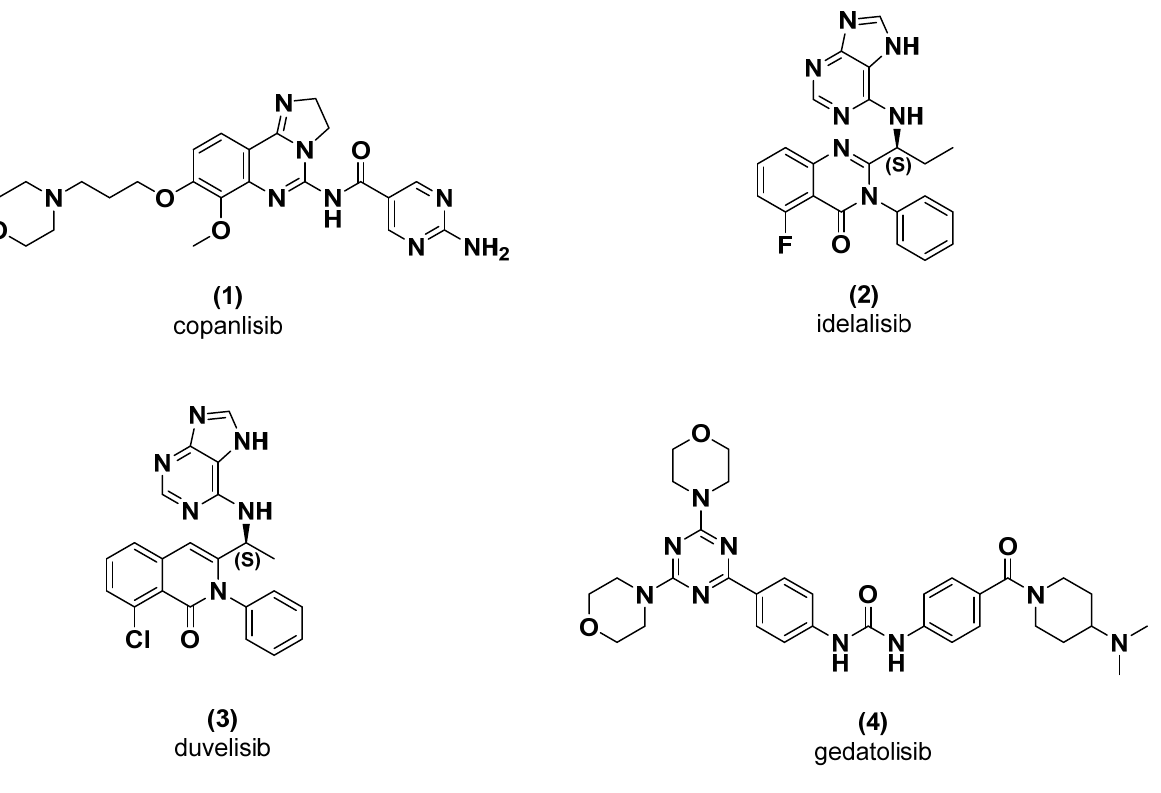
Figure 1. Examples of PI3K inhibitors.